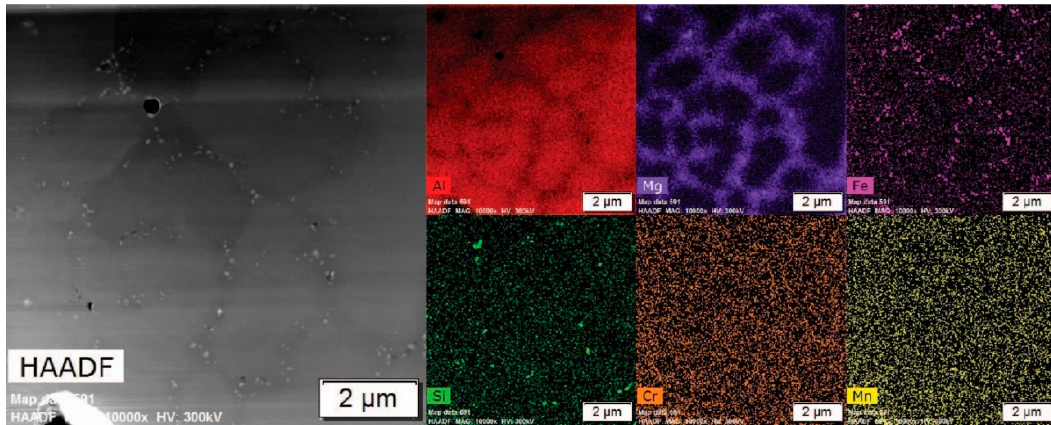
Figure 3. Low-magnification transition electron microscopy (TEM) micrographs of the as-atomized condition: HAADF and energy-dispersive X-ray spectroscopy (EDS) maps.